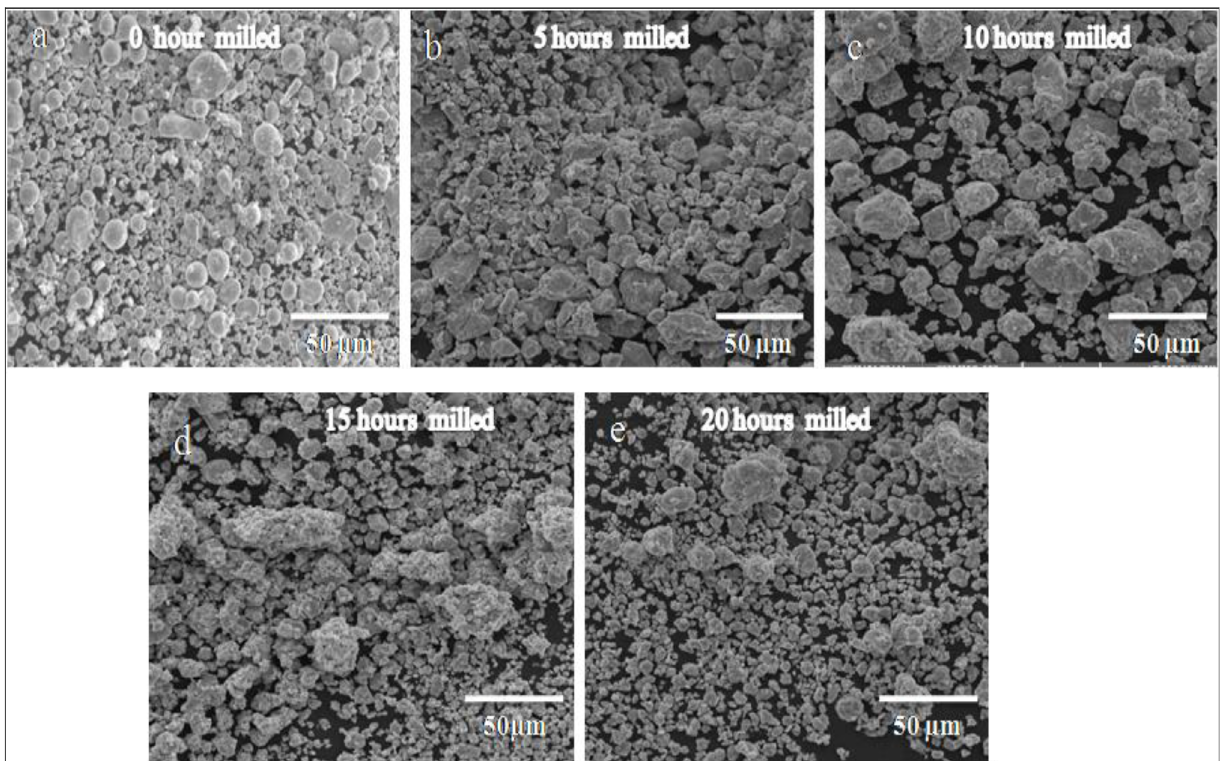
Fig. 5. SEM morphology of milled powders at different time intervals (a) 0 h, (b) 5 h, (c) 10 h, (d) 15h, (e) 20 h.